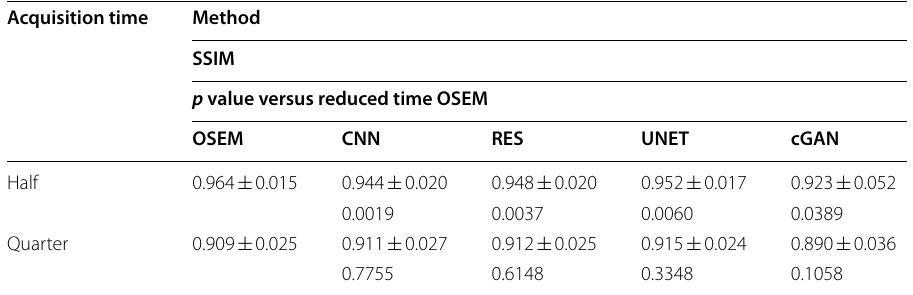
Table 3 Structural similarity index measure (mean different methods and acquisition times at stress